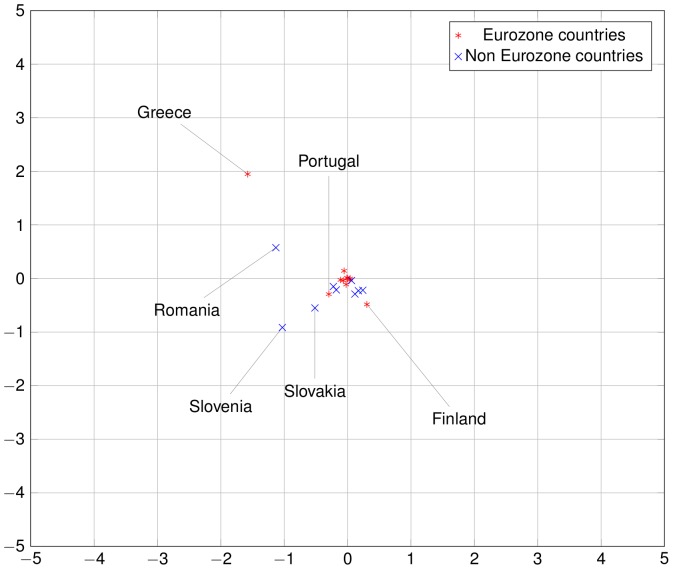
European economies in 2000.Compare with Figs. 9 and 11.